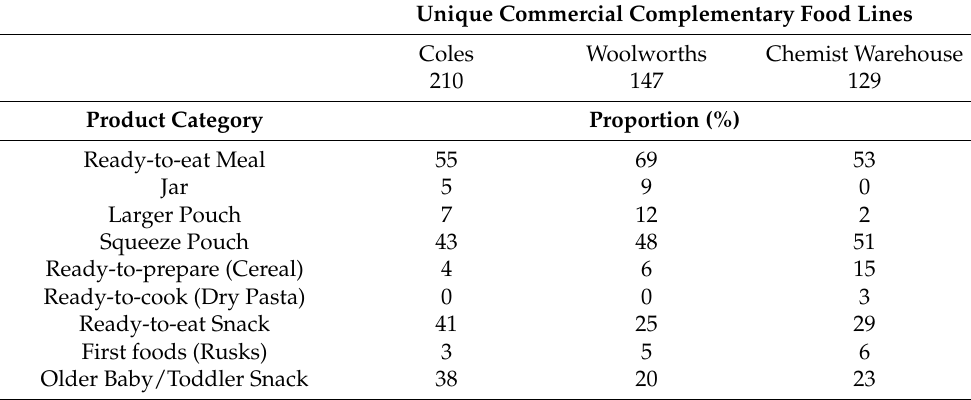
Table 1. Commercial complementary food lines by category per